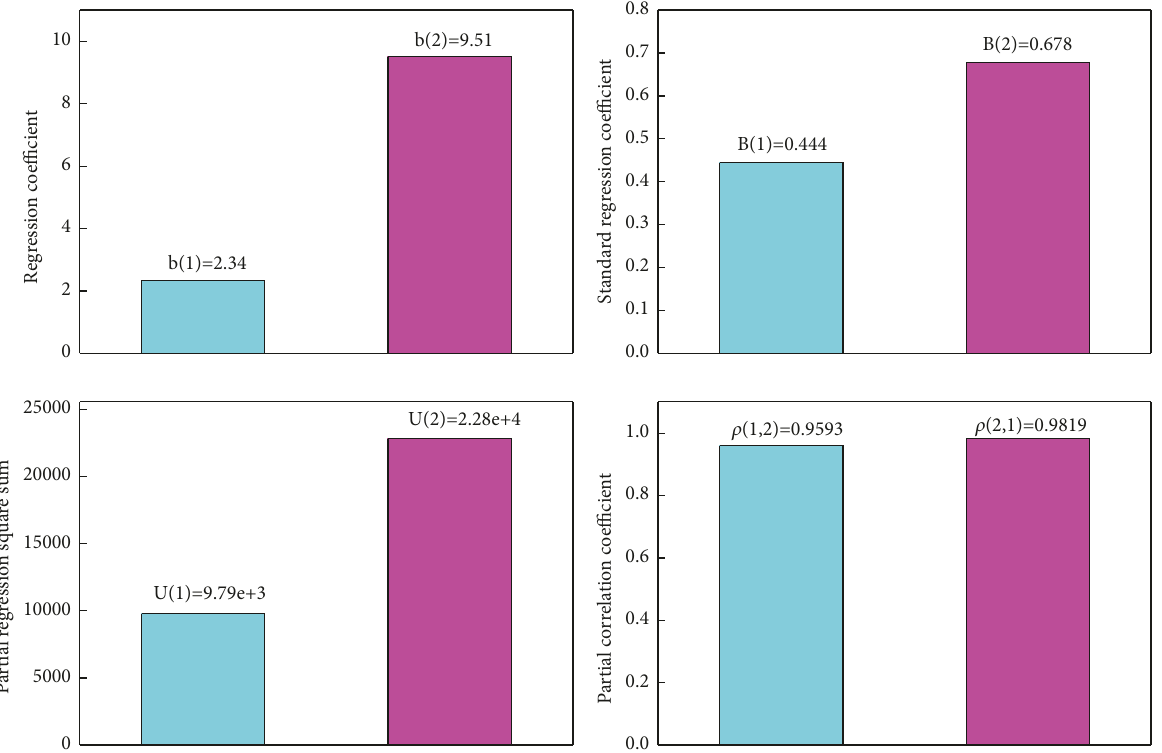
Figure 14: Regression analysis coefficient of equation (11).